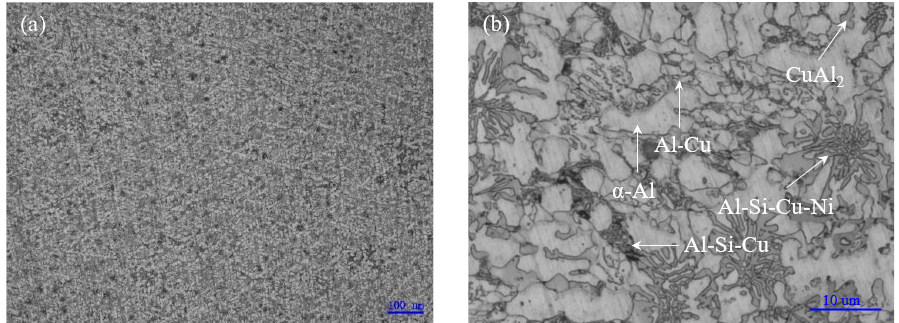
Figure 5. Optical microstructure of Al ‐ 5.0Si ‐ 20.5Cu ‐ 2.0Ni alloy in as ‐ cast condition: ( a ) Magnifica ‐ tion of 100×; ( b ) Magnification of 1000×.